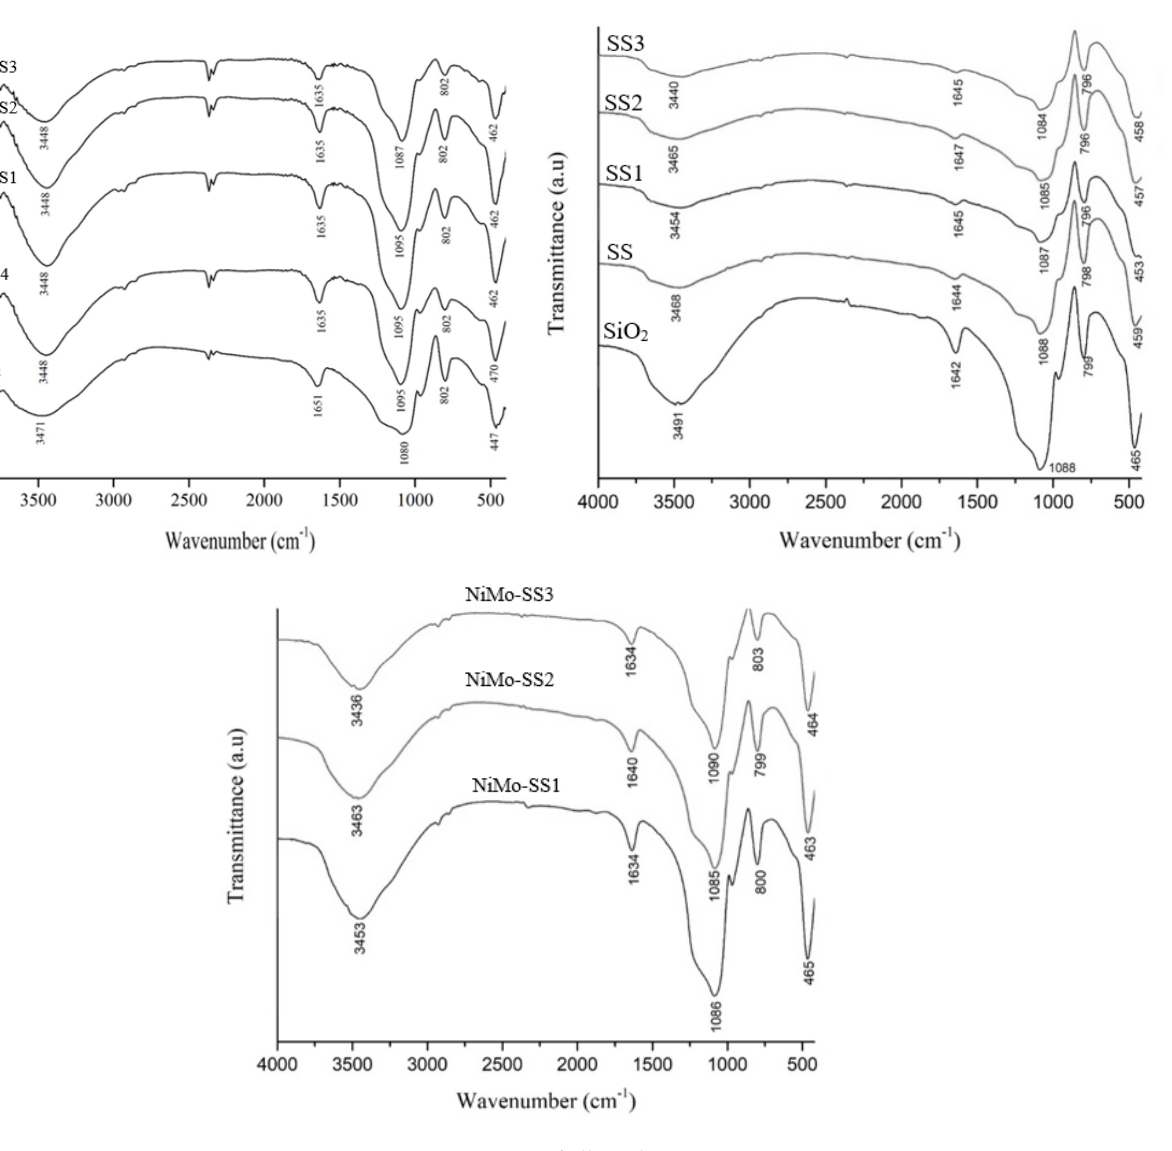
Figure 1. FTIR of all catalysts.